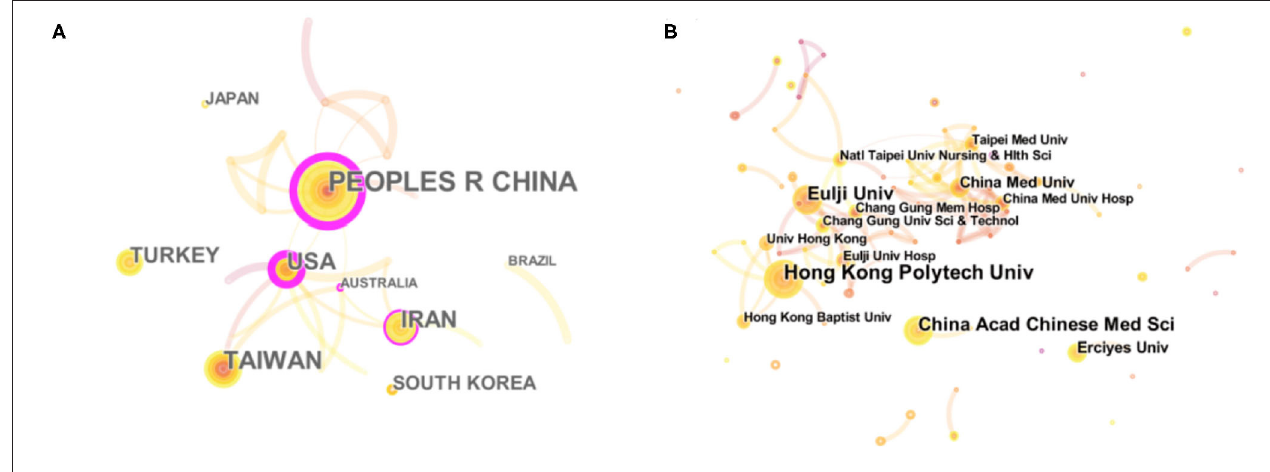
FIGURE 2 | Network map showing the relations between various countries (A) and the Institutions (B)